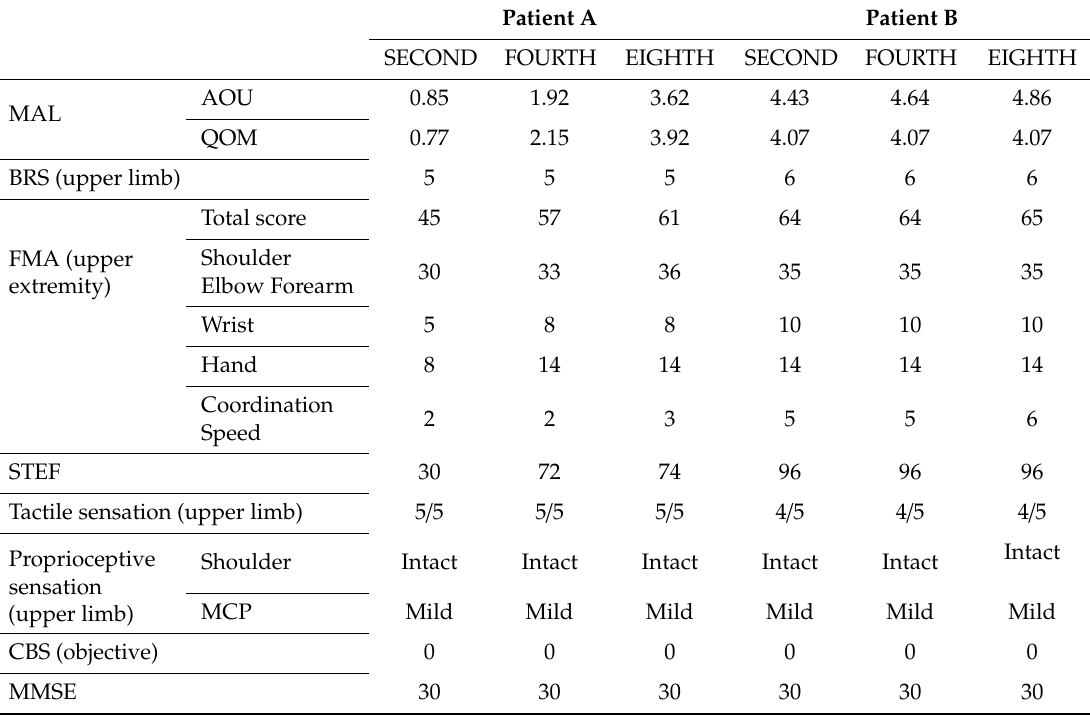
Table 1. Patients’ clinical